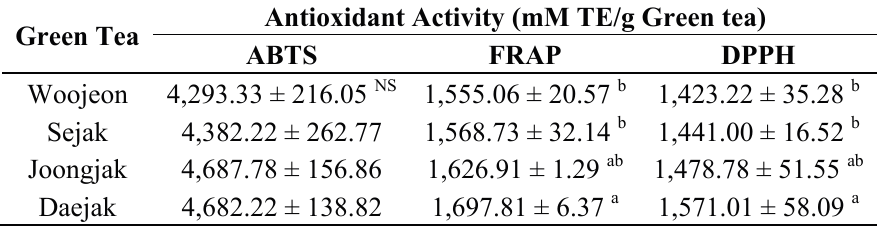
Table 2. Antioxidant activity of green tea with different plucking periods as determined by the ABTS, FRAP and DPPH